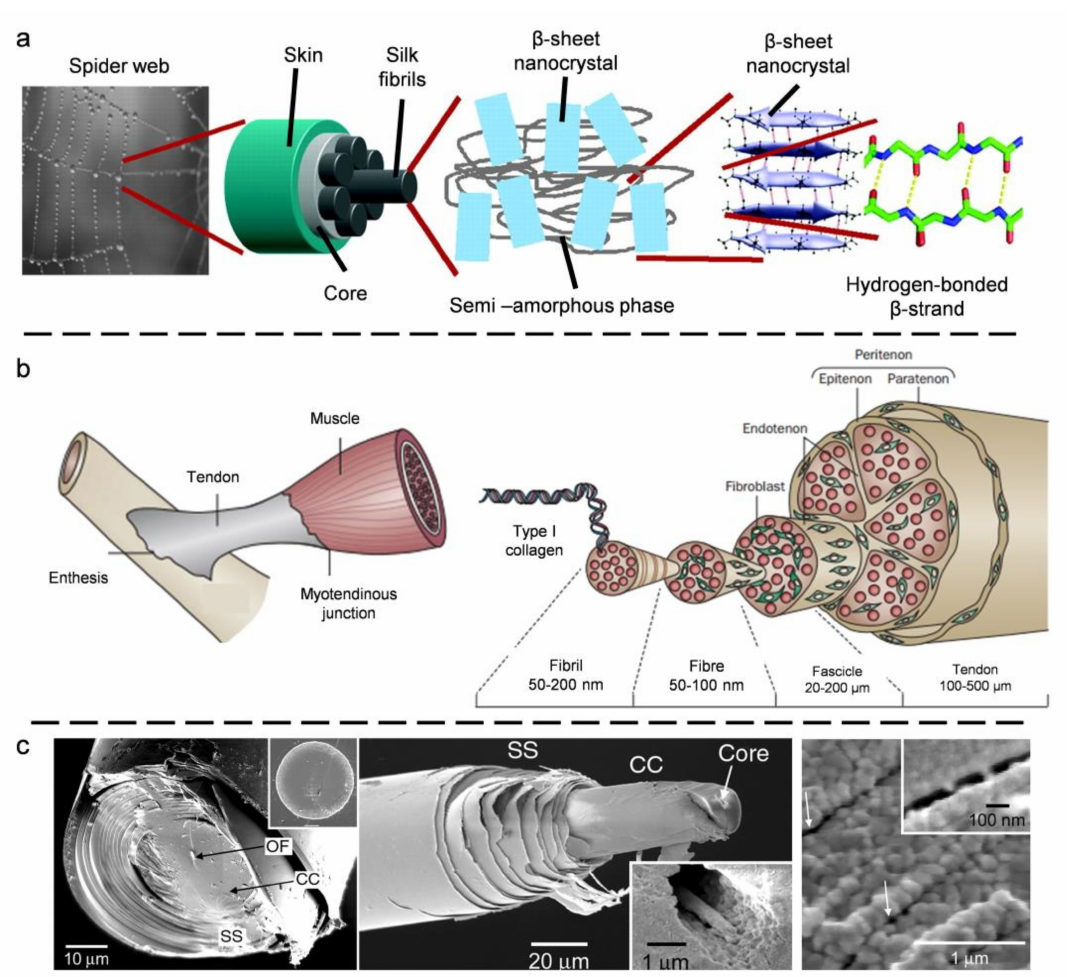
Figure 2. ( a ) Schematic of the hierarchical spider silk structure that ranges from nano to macro. Reprinted with permission from [52], copyright 2010 ROYAL SOC. ( b ) Typical hierarchical structure of a tendon. Reprinted with permission from [55], copyright 2015 NATURE RESEARCH. ( c ) Structural and compositional characterization of the basalia spicules. Reprinted with permission from [64], copyright 2004 NATL ACAD